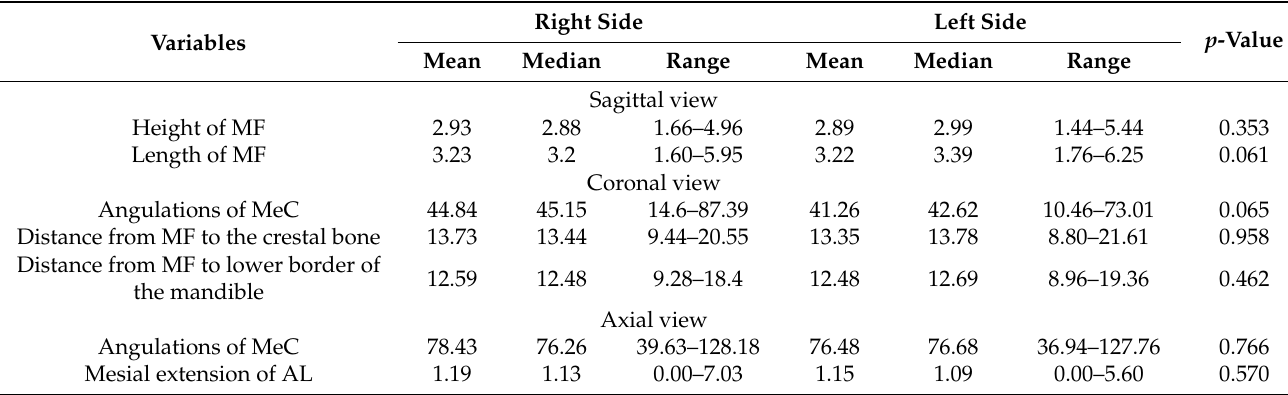
Table 5. Analysis of the dimension (in mm) and distance (in mm) of the mental foramen, angulations of the mental canal, and extension of the anterior loop in bilateral cases ( n =